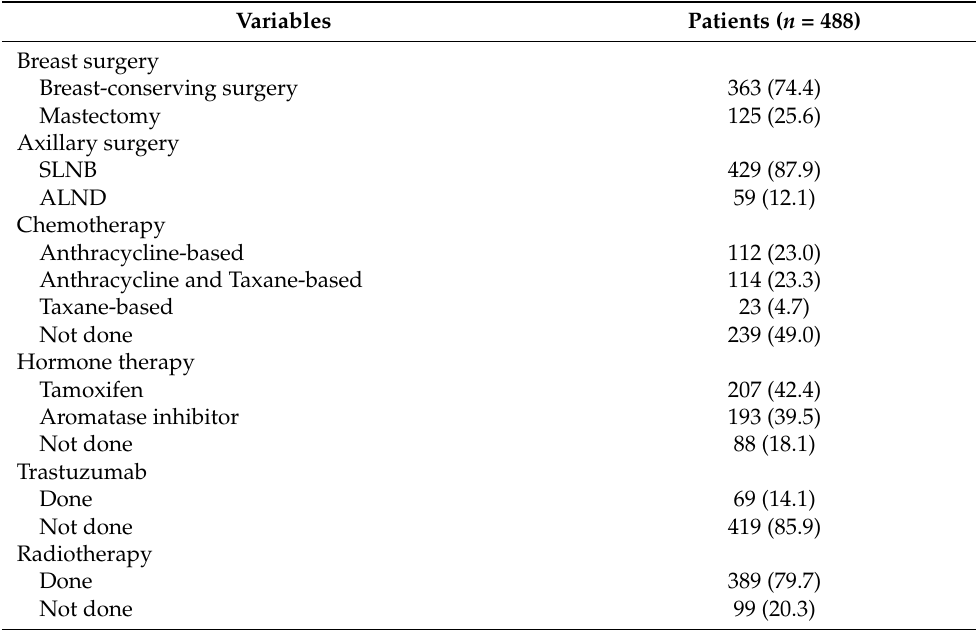
Table A1. Primary breast surgery and adjuvant treatments.